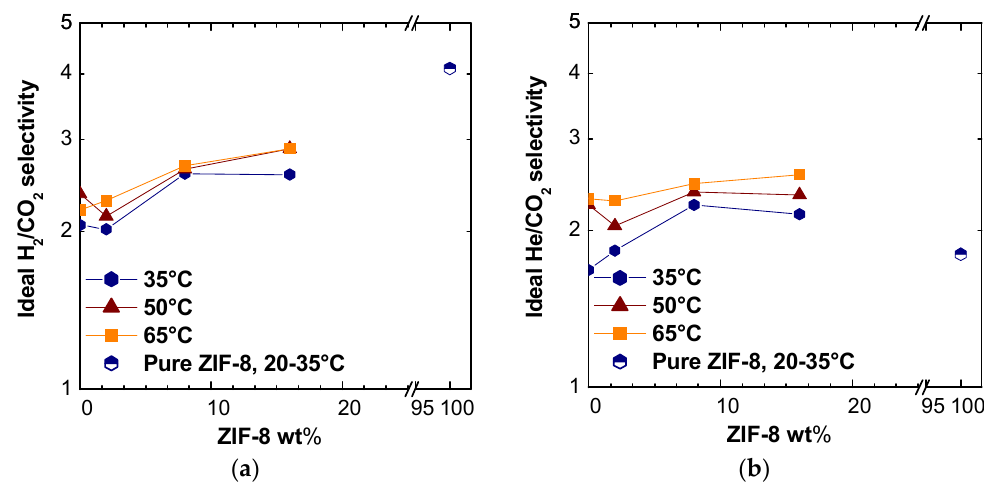
Figure 6. Selectivity in PSf/ZIF-8 mixed matrix membranes as a function of ZIF-8 content: ( a ) H 2 /CO 2 ; ( b ) He/CO 2 . For comparison, also, the average value reported for ZIF-8 is included at temperatures between 20 and 35 °C [27,42–48].